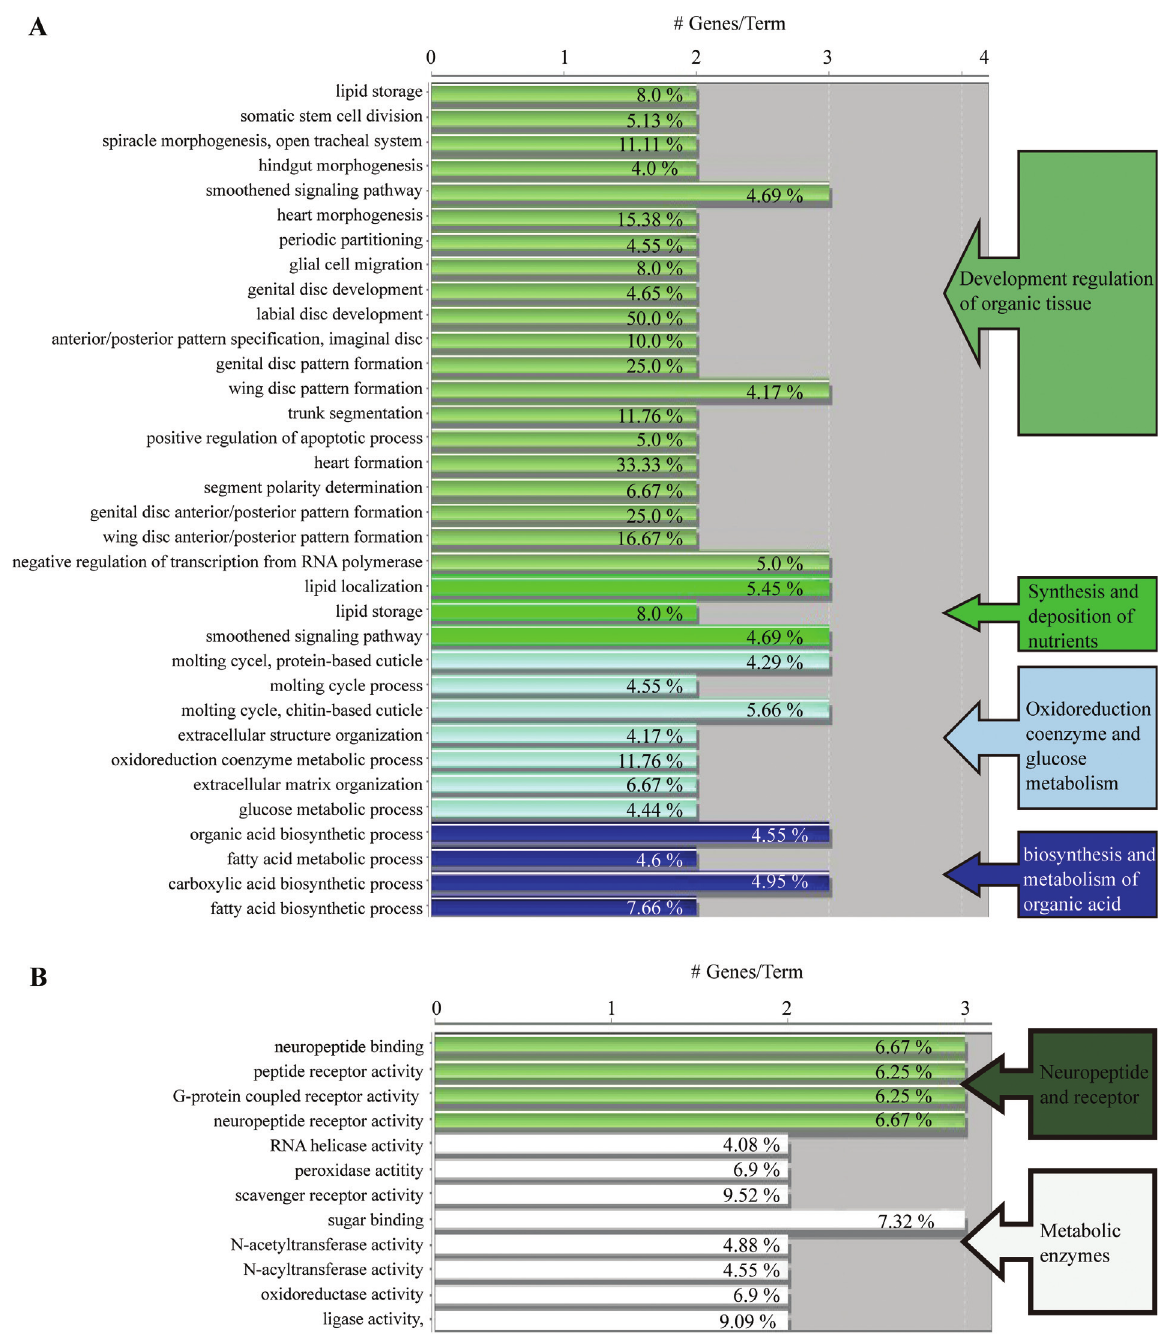
Figure 3 - Analysis on functional enrichment of the differently expressed genes in the high royal jelly producing bees (HRJB) and low royal jelly produc- ing bees (LRJB). Gene ontology (GO) pathway terms specific for differently expressed genes. The bars represent the number of genes associated with the terms. The percentage of genes per term is shown as a bar label. (A) Biological process enrichments of the identified genes. The gene functions are listed